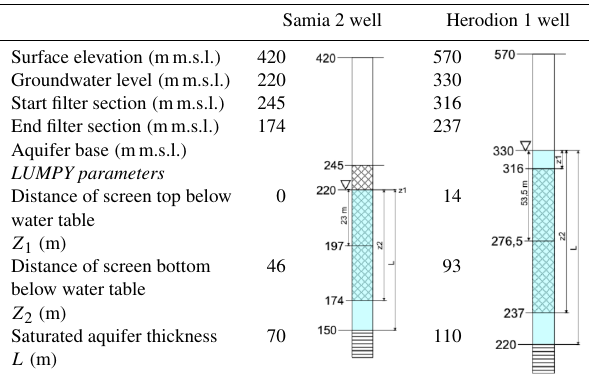
Table 2. Summary of DM, PM and PEM parameters for the wells Samia 2 and Herodion 1. Schematic graphs illustrate parameters and their individual levels in metres m.s.l. along both boreholes; the water-filled (saturated) part of the aquifer is indicated in blue; the screen section is indicated by a checkered pattern; and the aquitard is indicated by a striped